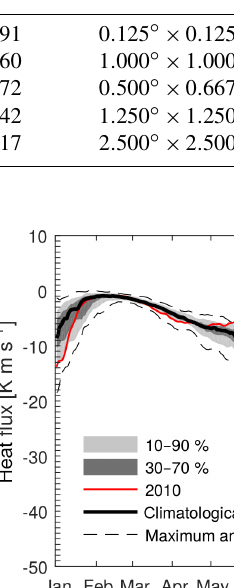
Table 2. Temporal and spatial resolution of meteorological data sets as considered in this study Data product Temporal Top Vertical